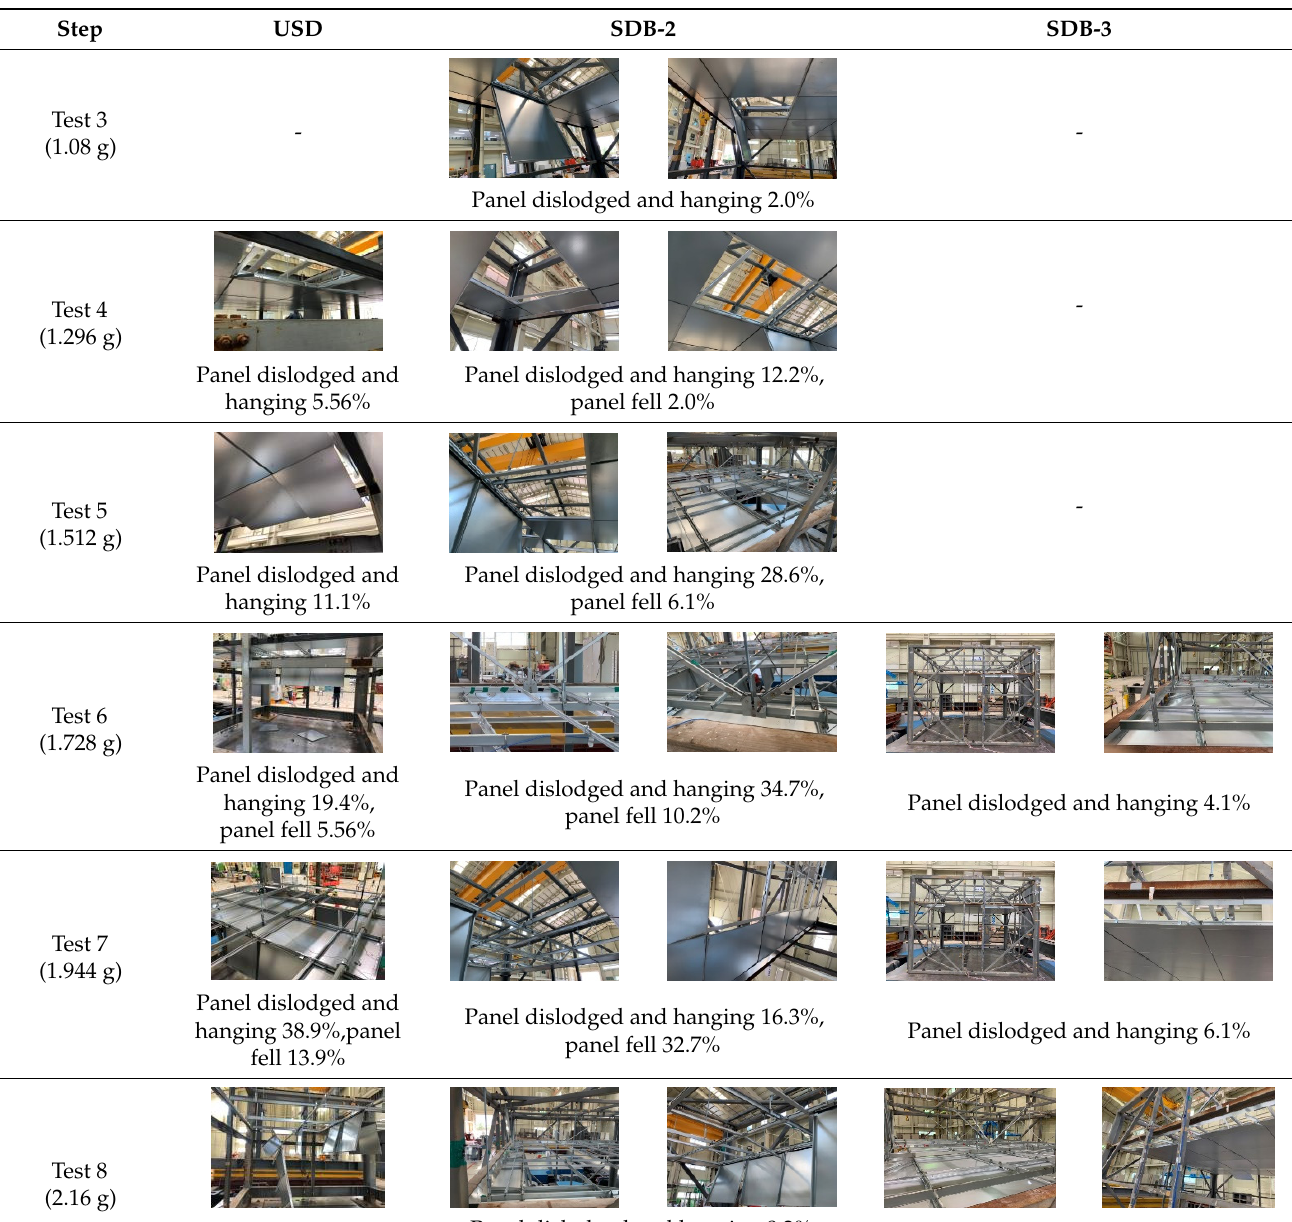
Table 5. Damage condition for each specimen.